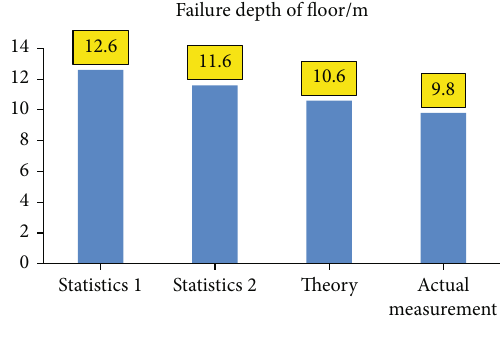
Figure 14: Failure depth of fl